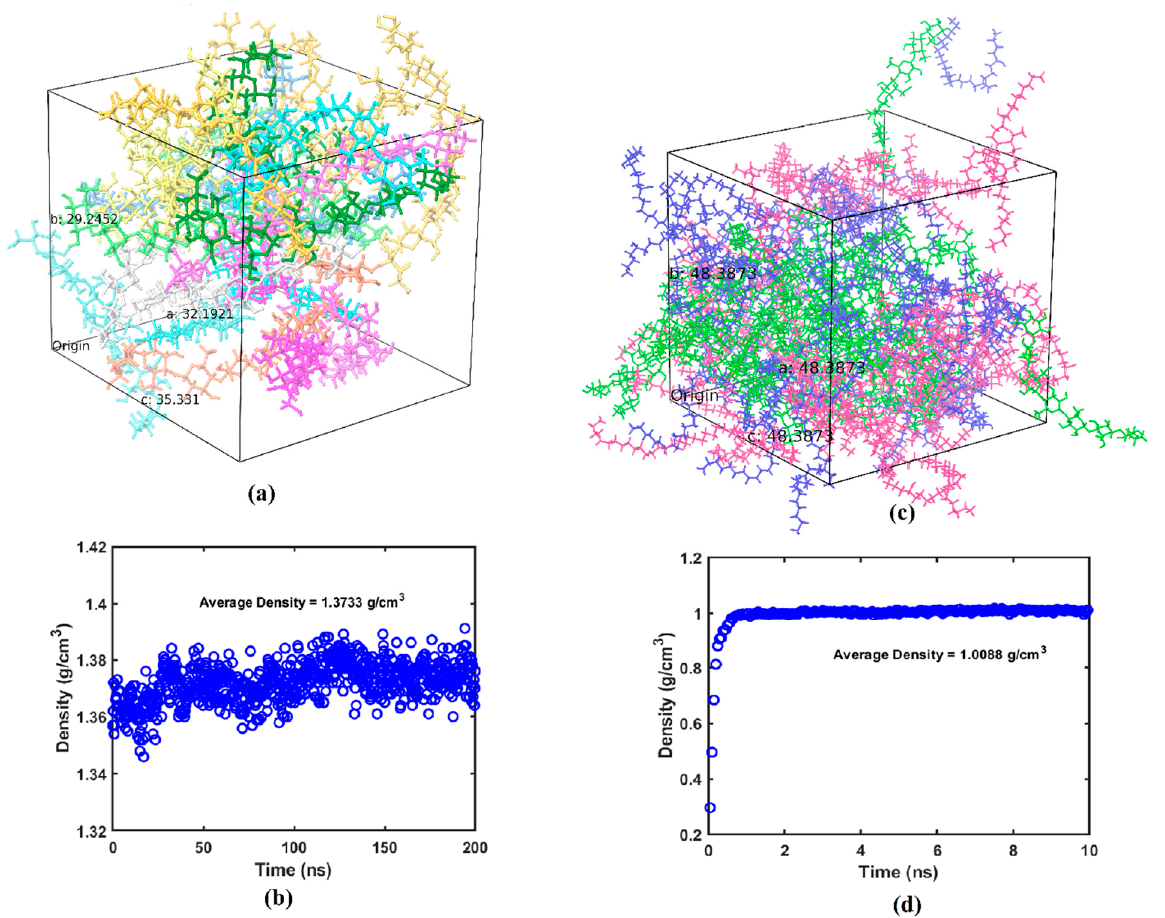
Figure 1. ( a ) Equilibrated amorphous cellulose (each chain is represented by a different color), ( b ) density-time profile for cellulose, ( c ) equilibrated adulose (cellulose chains are shown in green, nonacosane-10 ol molecules are shown in purple, nonacosane-5,10 diol molecules are shown in blue), ( d ) density-time profile for adulose.